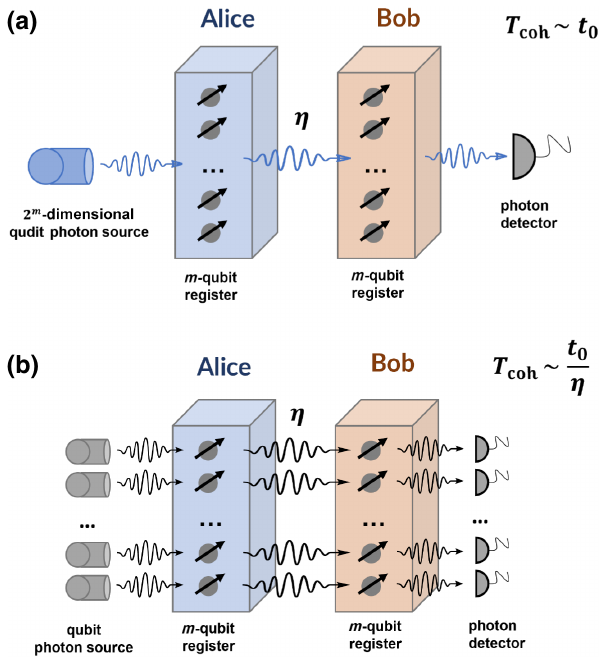
FIG. 1. (a) The qudit protocol for simultaneous generation of multiple entangled pairs. First, entanglement is generated between a single photonic qudit and all memory qubits on Alice’s side. A 2 m -dimensional photonic qudit is required for m memory qubits. The qudit is transmitted to Bob’s register and interacts with all memory qubits, thereby extending the entanglement to this register. A final measurement decouples the photonic state from the memory qubits and heralds the simultaneous generation of all entangled pairs. The required coherence time of the mem- ory qubits is T coh ∼ t 0 , where t 0 is the time for one attempt. (b) A comparative qubit-based protocol for the generation of multiple entangled pairs between two qubit registers. Entanglement is first created between multiple photonic qubits and the memory qubits of Alice’s register in a parallel fashion. The photons (each entan- gled with one memory qubit) are transmitted to Bob’s register to interact with his memory qubits and measurements decouple the photonic states from the memory-qubit states and herald the successful generation of Bell pairs. To efficiently generate mul- tiple pairs, successfully generated pairs have to be stored while the remaining unsuccessful pairs are reattempted. This leads to a required coherence time of the spin gates of T coh ∼ t 0 /η , where η is the transmission probability.